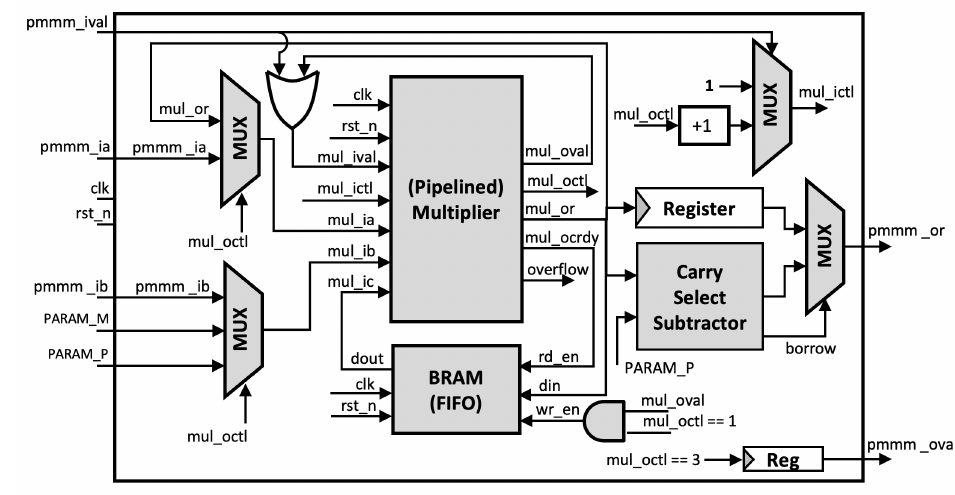
Figure 5. Proposed Pipelined Montgomery Modular Multiplier